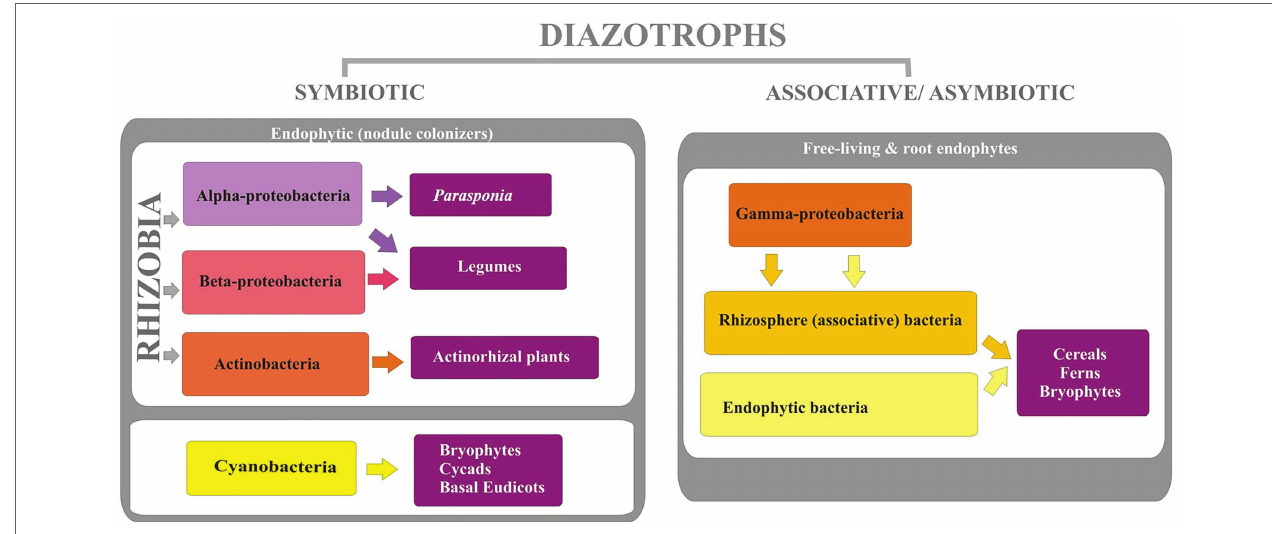
FIGURE 2 | List of different diazotrophs and their